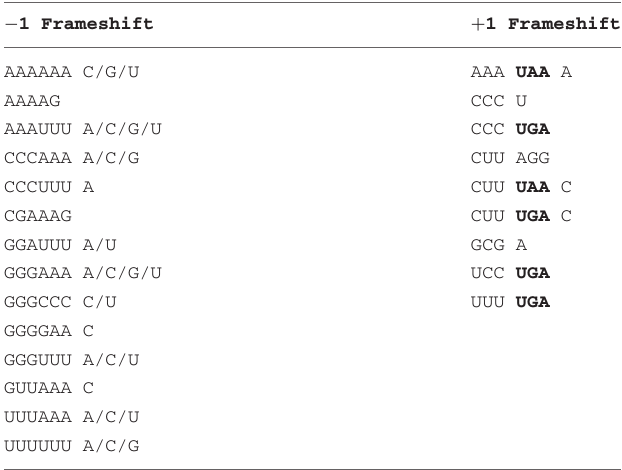
Table 2 | Slippery sequences used by FSDB for prediction of out-of-frame